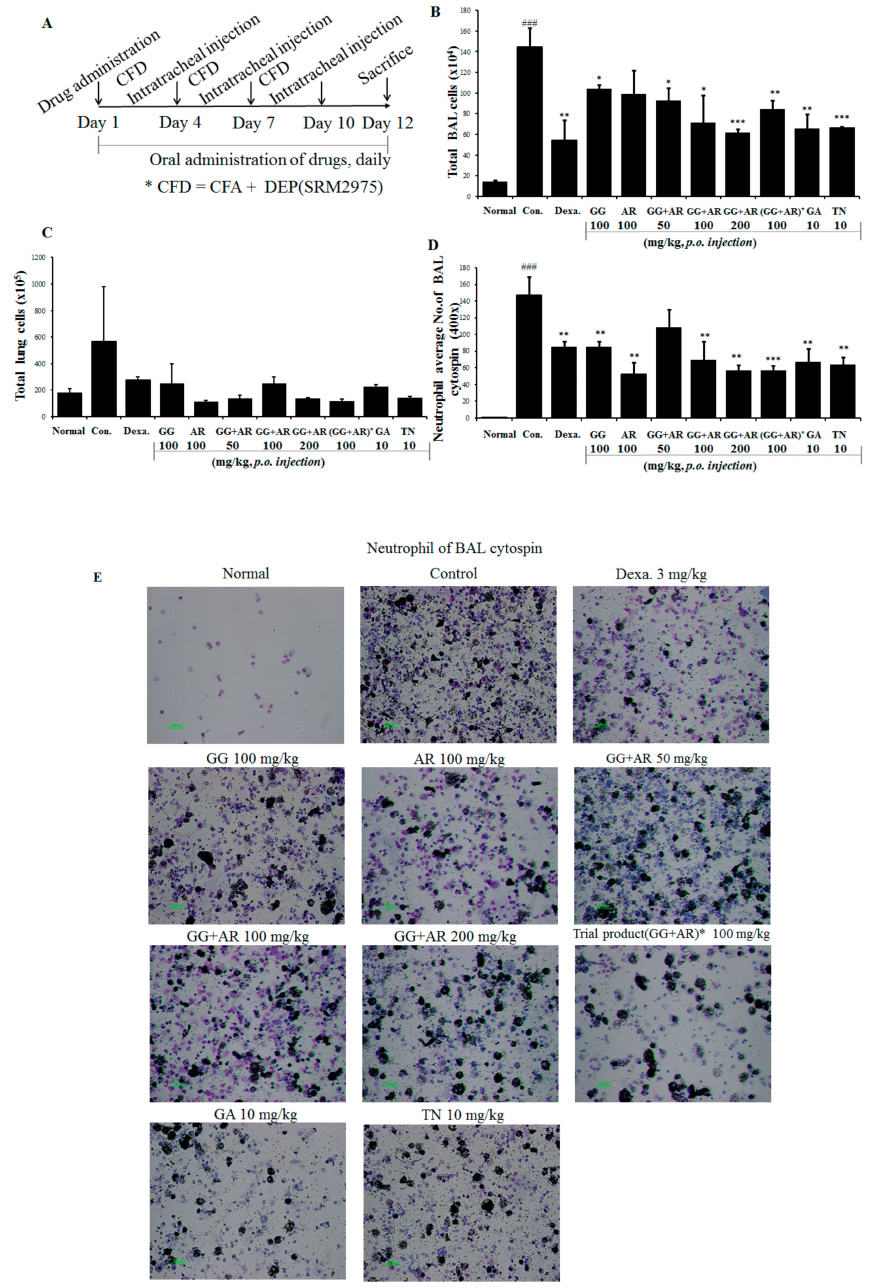
Figure 2. Schematic diagram of CFD-induced chronic obstructive pulmonary disease (COPD) model mice ( A ). Total bronchoalveolar lavage (BAL) cell numbers of each treatment group ( B ). Total lung cell numbers of each treatment group ( C ). Neutrophil numbers in the BALF cytospin of each treatment group ( D ). Neutrophilic inflammation cytospin image ( × 400 images of cytospin slide) shown by di ff erential leukocyte staining from BAL slides ( E ). Normal: normal group; Con.: CFD, CFD-induced COPD model group; Dexa.: CFD solution and administrated with dexamethasone 3 mg / kg group; GG 100: CFD solution and administrated with GG extract 100 mg / kg group; AR 100: CFD solution and administrated with AR extract 100 mg / kg group; GG + AR 50: CFD solution and administrated with GG plus AR extract 50 mg / kg group; GG + AR 100: CFD solution and administrated with GG plus AR extract 100 mg / kg group; GG + AR 200: CFD solution and administrated with GG plus AR extract 200 mg / kg group; GG + AR 100* (trial product): CFD solution and administrated with GG plus AR (trial product) 100 mg / kg group; GA 10: CFD solution and administrated with GA 10 mg / kg